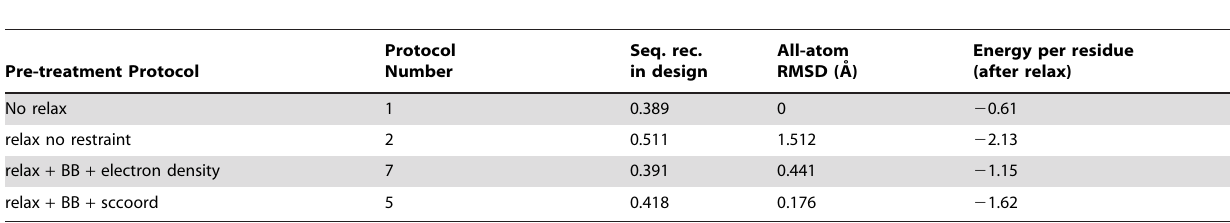
Table 2. RMSD after restrained relax, and sequence recovery after Rosetta design over a 36-protein subset using electron density